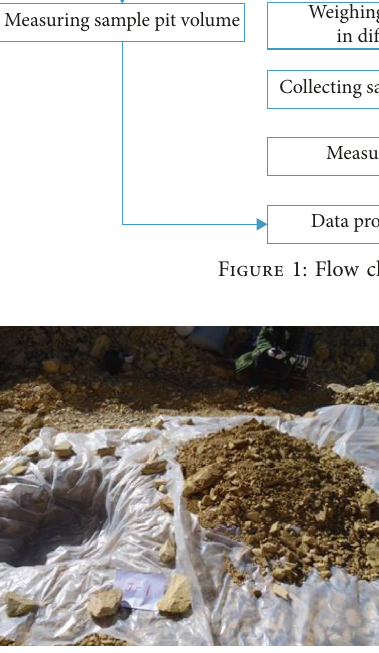
Figure 2: Sample pit J1 and waste rocks digged from it. Figure 3: Sieved sample waste rocks with grain size